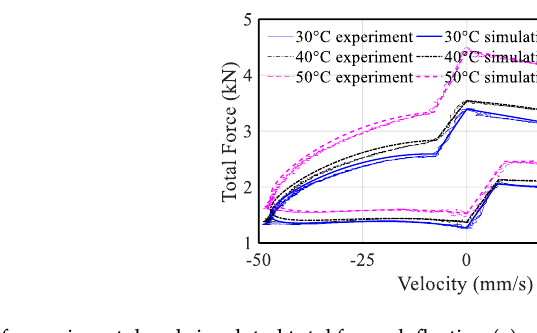
Figure 5. Comparisons of experimental and simulated total force-deflection ( a ) and total force-ve- locity ( b ) relationships at different temperatures (2 Hz). Figure 6. Comparisons of experimental and simulated total force-deflection ( a ) and total force-ve- locity ( b ) relationships at different temperatures (8 Hz). Figure 7. Comparisons of experimental and simulated gas pressure-deflection ( a ), pressure differ- ence-velocity ( b ), seal friction-deflection ( c ), and seal friction-velocity ( d ) relationships at different temperatures (0.5 Hz).